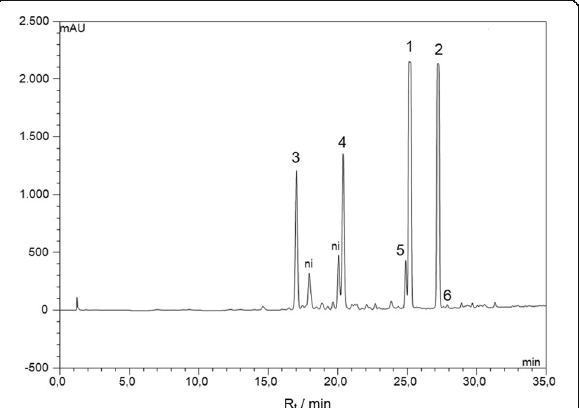
Fig. 1 HPLC/HRESIMS analysis of crude n-hexane extract from twigs of N. leucantha. Compound 1 m/z 349.1423 [M + Na] + , compound 2 m/z 363.1585 [M + Na] + , compound 3 m/z 365.1237 [M + Na] + , compound 4 m/z 379.1506 [M + Na] + , compound 5 m/z